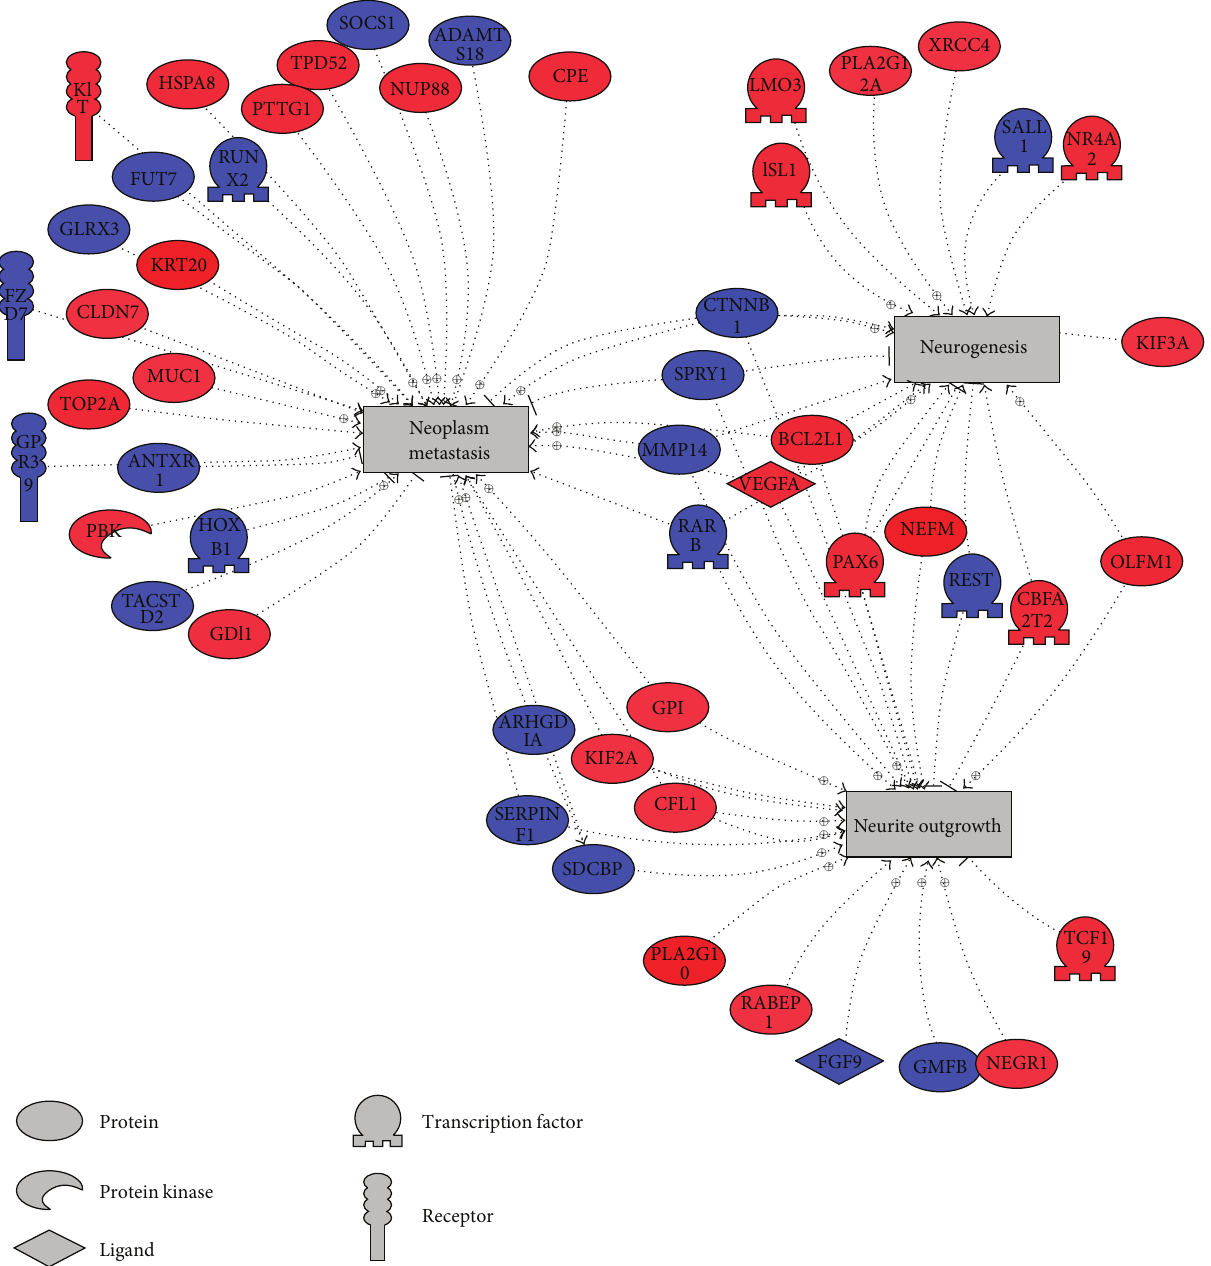
Figure3:Subnetworkofgenesinvolvedinregulatingneoplasmmetastasis,neuriteoutgrowth,andneurogenesis.Genesinredareupregulated in poor prognosis; blue,